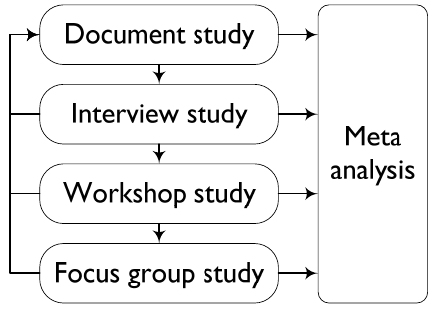
Figure 2. Flowchart of the research process.